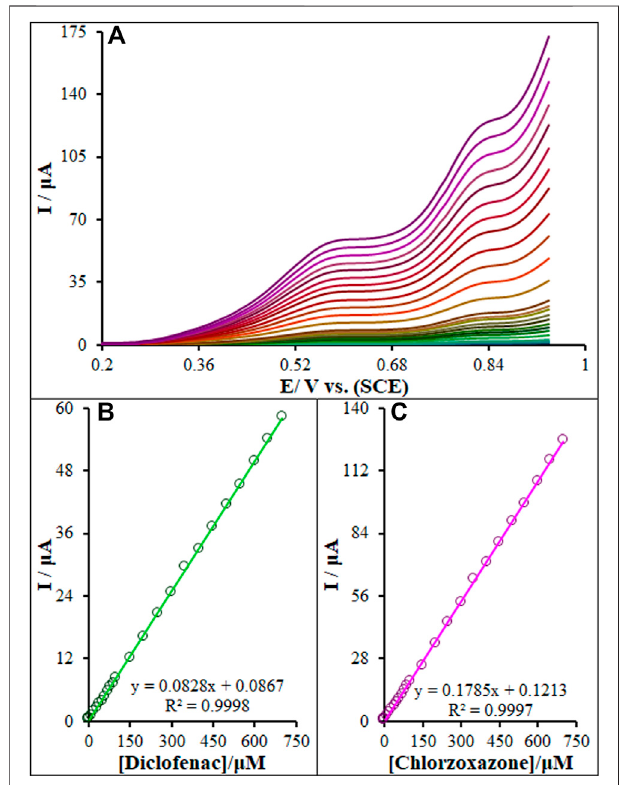
FIGURE 12 | (A) DPVs of La 2 O 3 @SF-L Cu 2 S/GCE in 0.1 M (pH 7.0) containing different concentrations of diclofenac and chlorzoxazone (from inner to outer curve): 0.01, 0.1, 1.0, 10.0, 20.0, 30.0, 40.0, 50.0, 60.0, 70.0, 80.0, 90.0, 100.0, 150.0, 200.0, 250.0, 300.0, 350.0, 400.0, 450.0, 500.0, 550.0, 600.0, 650.0, and 700.0 µM. (B) and (C) Plots of the electrocatalytic peak currents as a function of diclofenac and chlorzoxazone concentrations in the range of 0.01 – 700.0 µM,